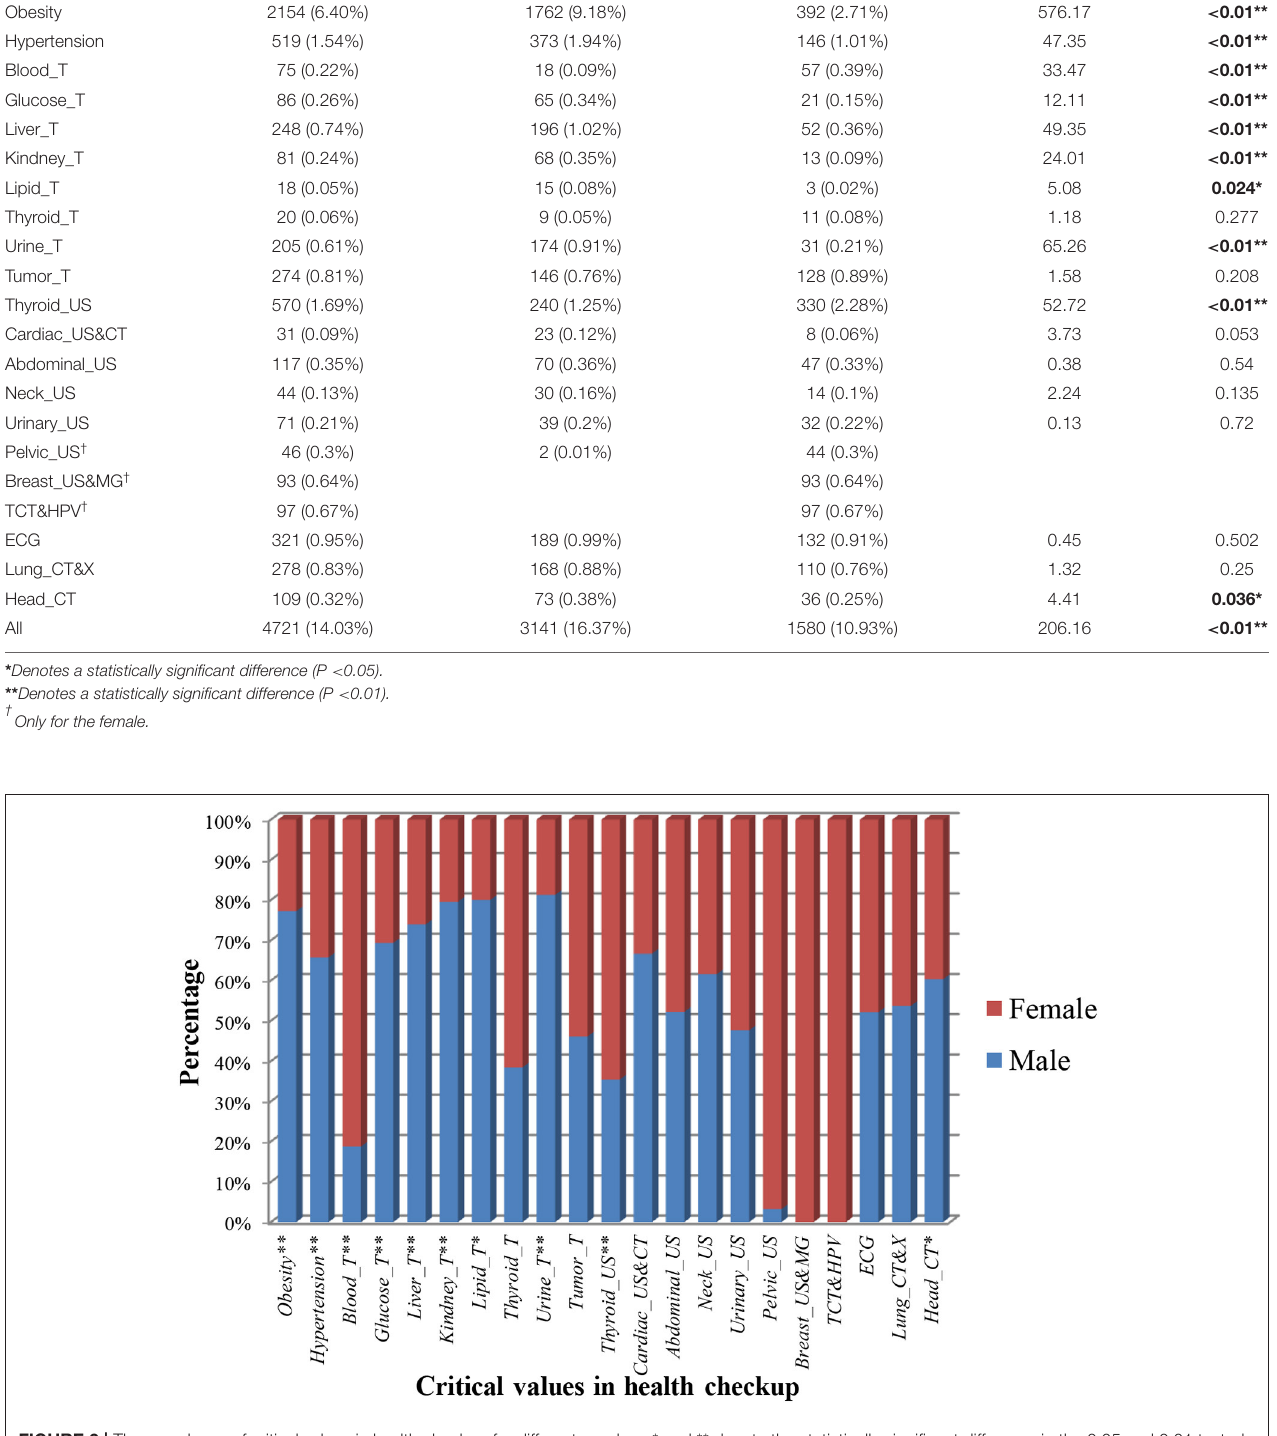
Frontiers in Public Health |